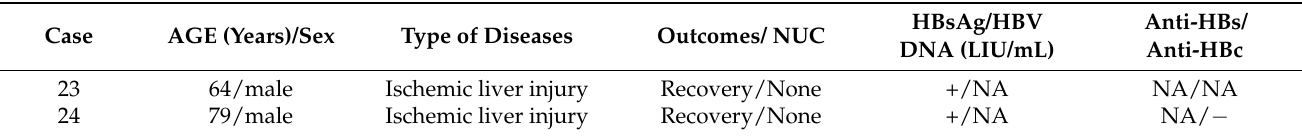
Table 3. Non-hepatitis B virus (HBV) suspected patients who had alanine transaminase (ALT) elevations higher than 1000 IU/L among the HBV surface antigen (HBsAg)-positive group.